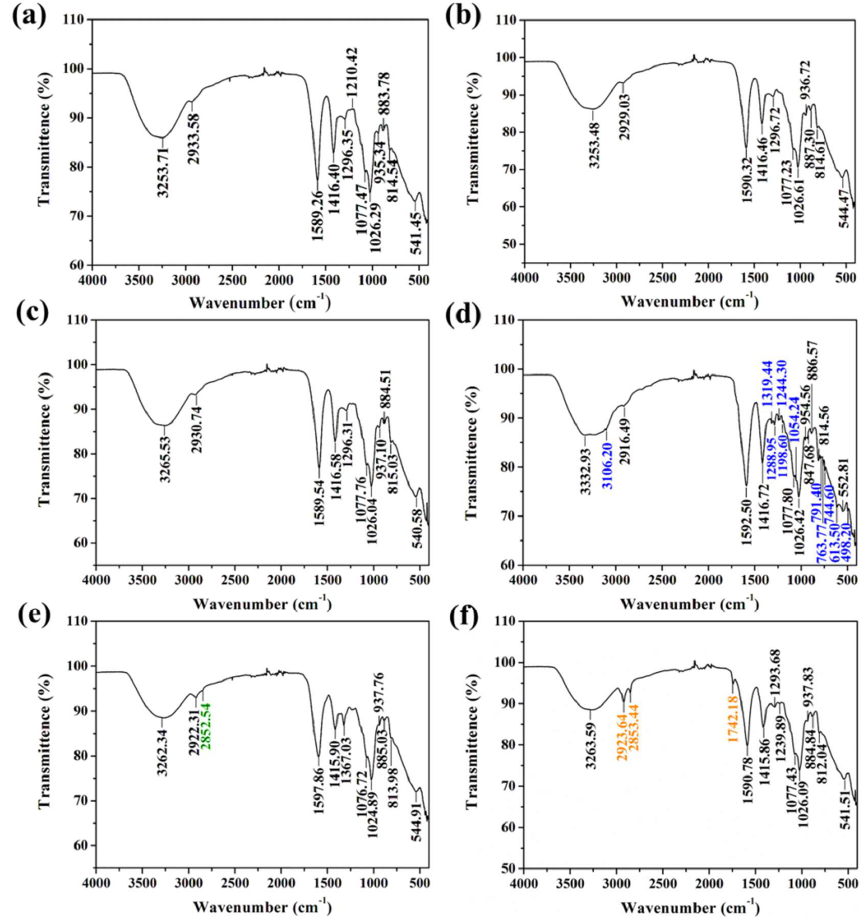
Figure 2. FT-IR spectra of the polishing pad with di ff erent catalyst: ( a ) pristine pad, ( b ) synthetic soft abrasives, ( c ) citric acid, ( d ) theophylline, ( e ) green tea powder, and ( f ) co ff ee